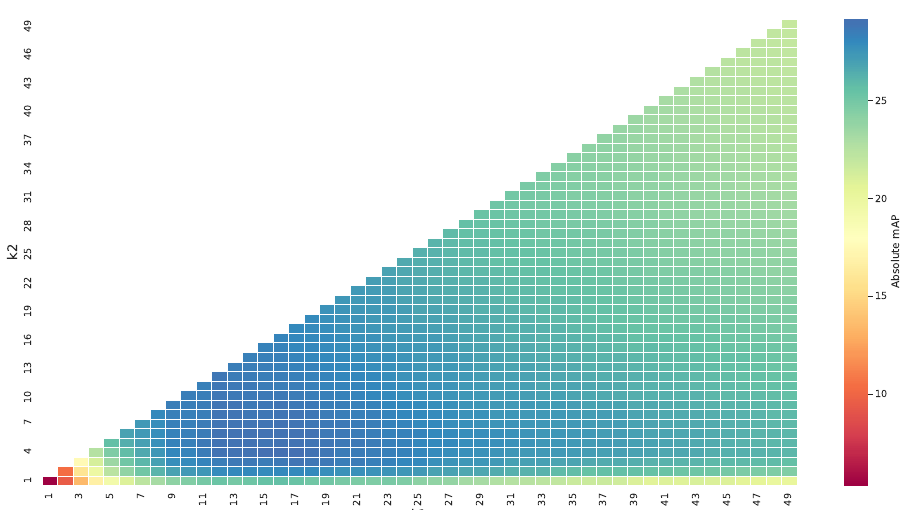
Figure 9. Heatmap of the absolute mAP against k 1 and k 2 with the MD method (best seen in color).